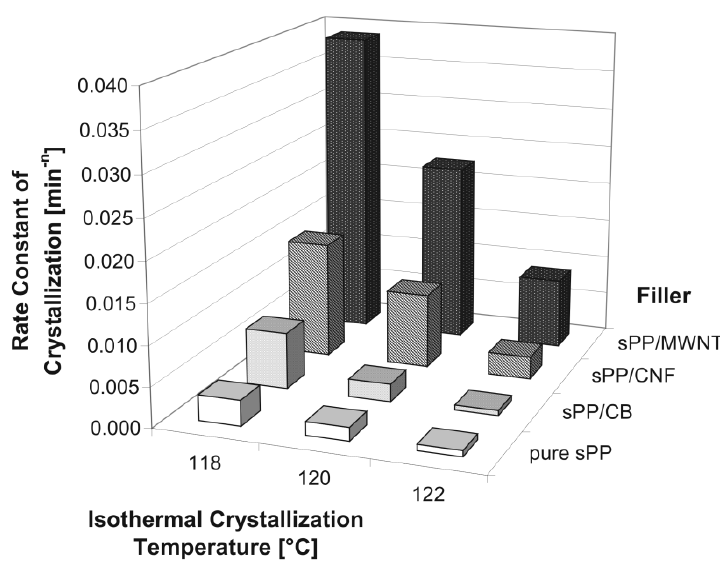
Figure 10. Crystallization rate in dependence of different syndiotactic PP composite materials and by three isothermal crystallization temperatures, CB = carbon black for comparision.